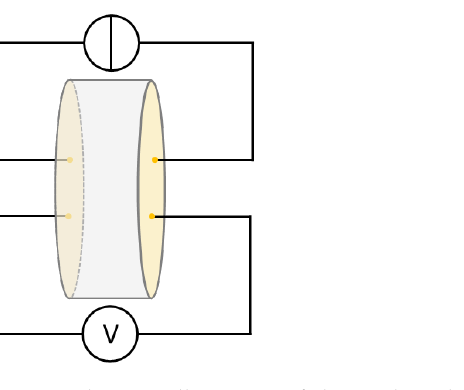
Figure 1. Schematic illustration of electrical conductivity measurement setup.